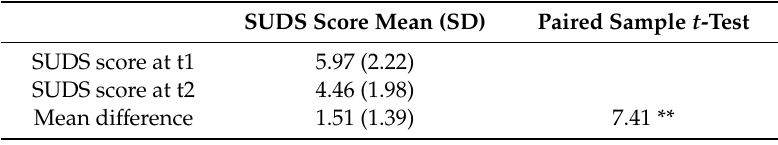
Table 2. Pre–post Subjective Units of Distress Scale (SUDs) scores ( N = 51).